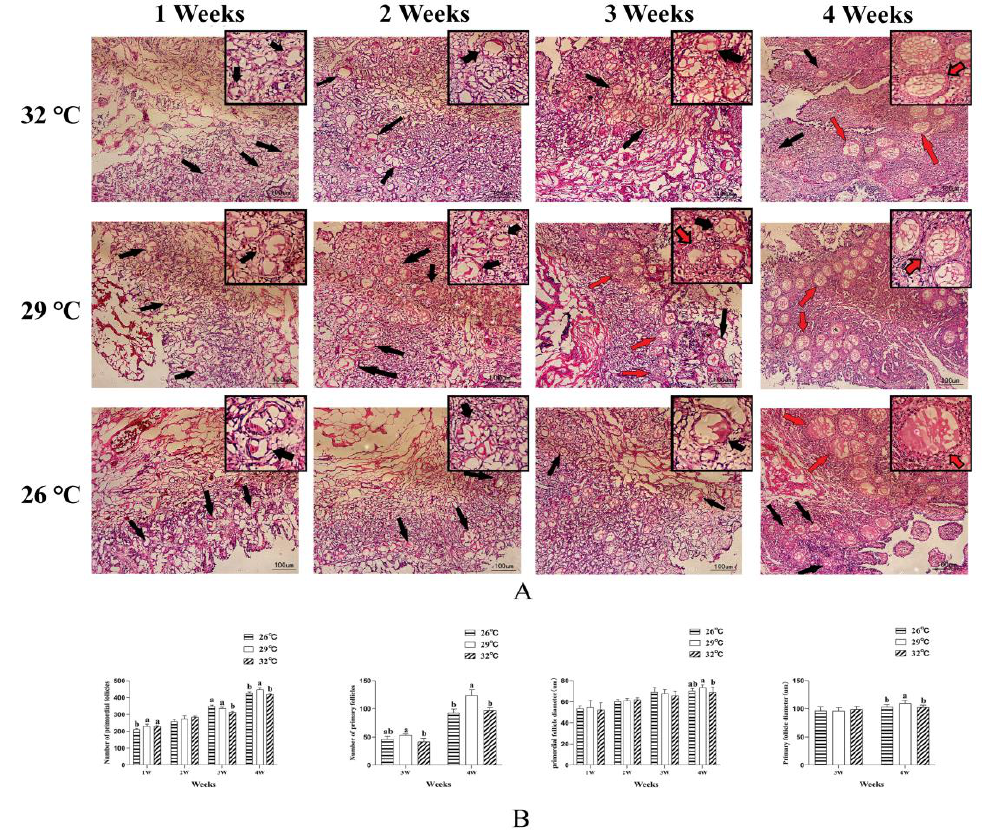
Figure 3. Effect of temperature on follicles’ development of goslings at each week of age. ( A ) HE sections of gosling ovaries at each week of age, a higher magnification is presented in the inserts. Black arrows refer to primordial follicles and red arrows refer to primary follicles. ( B ) Effects of temperature on the number of follicles and diameter of follicles in goslings of different weeks of age. a,b Different letters in the same stage within an index indicate a significant difference ( p < 0.05).